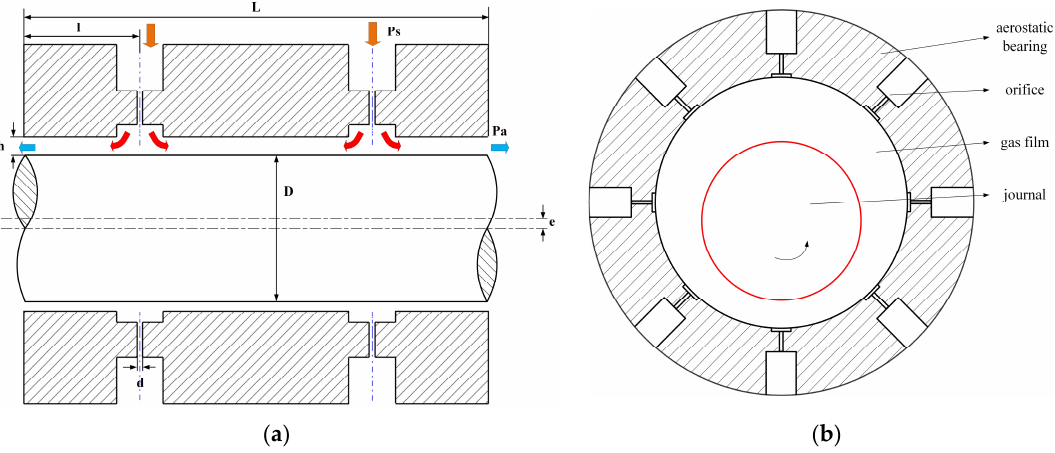
Figure 1. ( a ) Structure diagram of aerostatic bearing; ( b ) orifice distribution